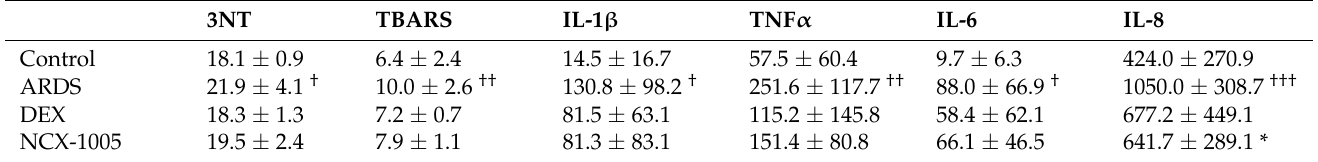
Table 3. Degree of inflammation and oxidation in plasma at the end of experiment. Levels of cytokines, IL-1 β , TNF α , IL-6, and IL-8 (all in pg/mL) and protein (3-nitrotyrosine, 3NT, nmol) and lipid oxidation (thiobarbituric acid-reactive substances TBARS, mmol MDA) in Control group, ARDS-untreated group, and ARDS group treated with dexamethasone or with NCX-1005. Data are presented as means ± SD. Statistical comparisons: for ARDS vs. Control † p < 0.05, †† p < 0.01, ††† p < 0.001; and for NCX-1005 vs. ARDS * p <